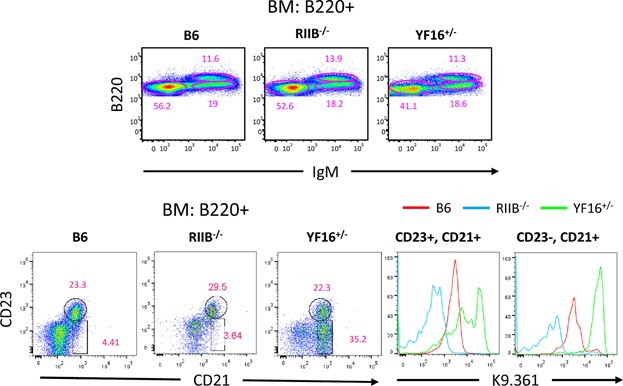
Primary development of B cells in FY16+/− mice in the bone marrow. Panel A: Flow cytometric analysis of total BM B220+ cells from mice of the indicated genotypes for surface IgM and B220 levels (upper panels). The percentage of B220low IgMneg pre-pro B, B220intermediate IgMhigh immature and B220high IgMlow mature B cells are shown in three separate gates. The lower panels show the results of analysis of levels of CD23 and CD21/35 on BM B220+ cells as well as levels of K9.361 staining on subpopulations expressing different levels of CD23.